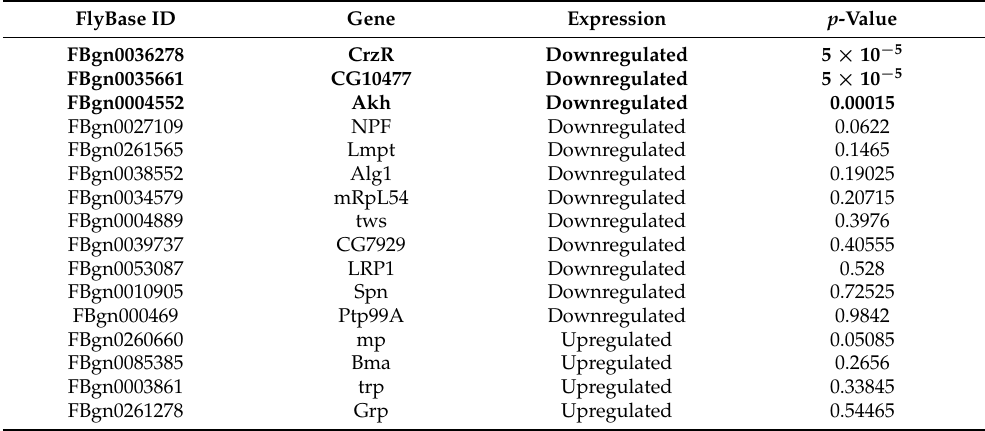
Table 1. Genes related to food intake changed by Hmgcr